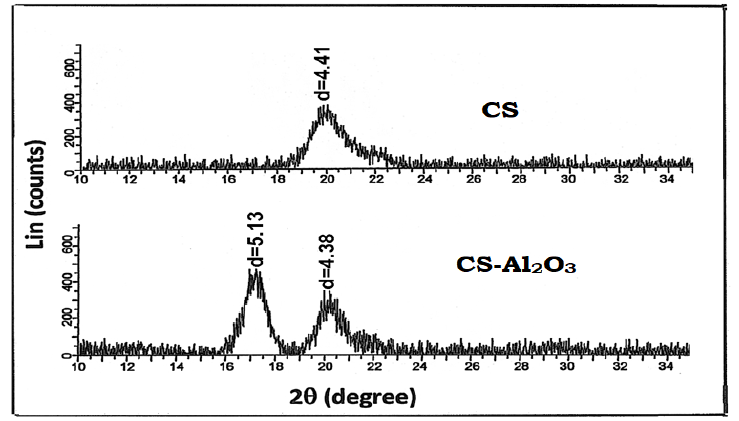
Figure 2. XRD of chitosan − Al 2 O 3 nanocomposite as compared to the native chitosan.